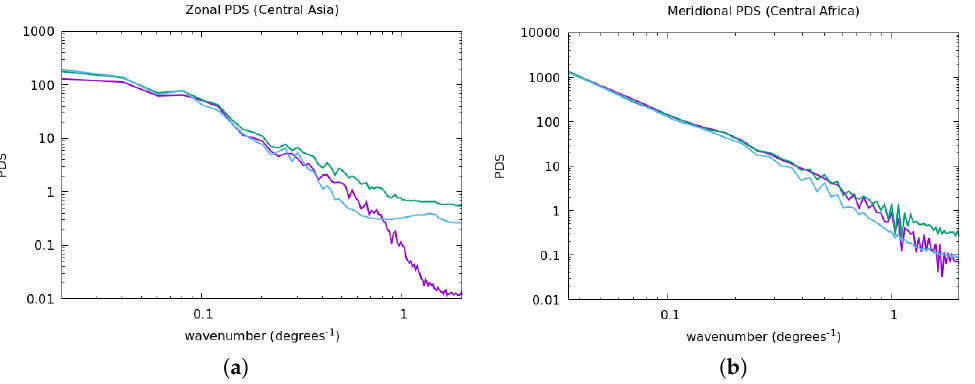
Figure 6. Log-log plots of the Power Density Spectra (PDS) of the three datasets: green represents Soil Moisture and Ocean Salinity (SMOS) nominal, blue represents SMOS nodal sampling (NS), and purple represents Soil Moisture Active Passive (SMAP). ( a ) Central Asia and ( b ) Central